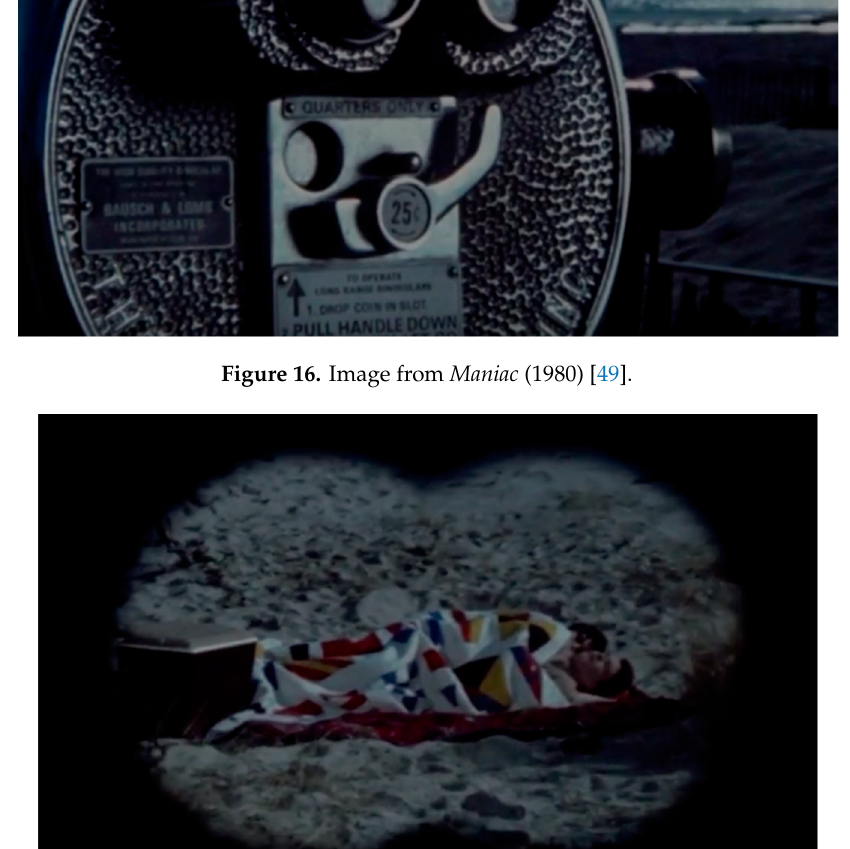
Figure 17. Image from Maniac (1980) [49].